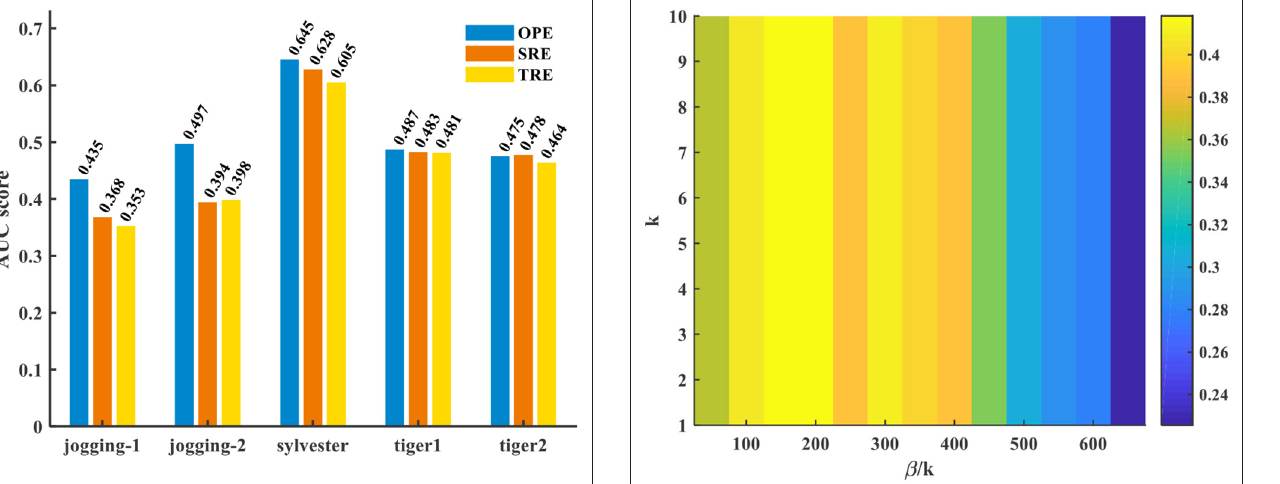
FIGURE 11 | Influence of the model hyper-parameters.